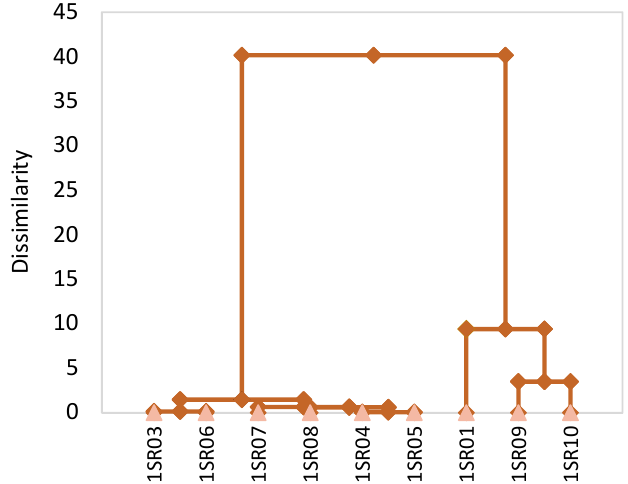
Fig. 2: Dendrogram view of cluster analysis for DOE monitoring stations